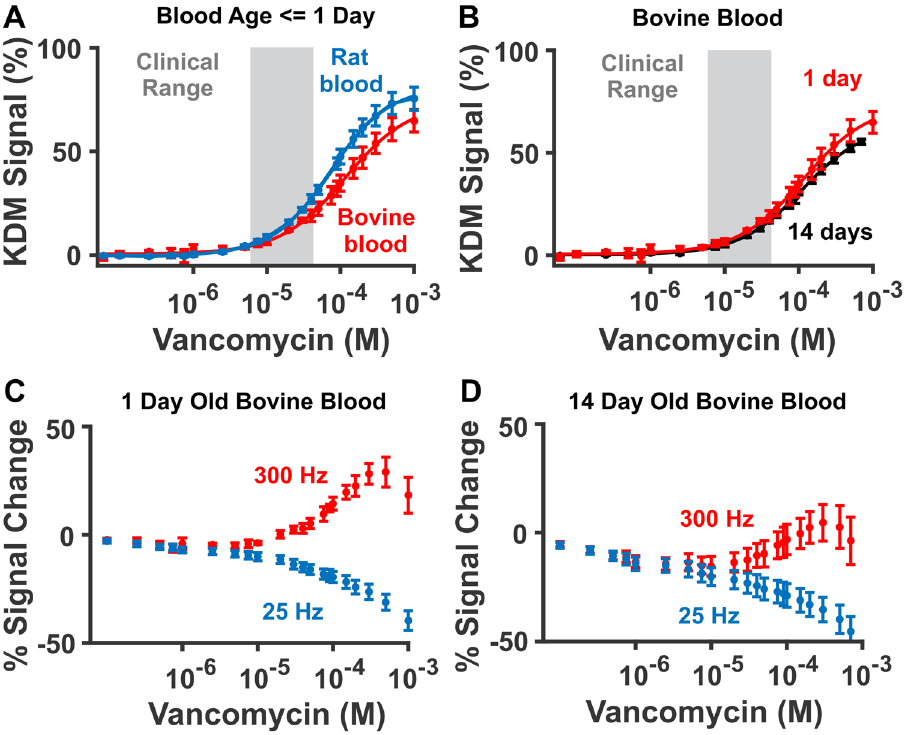
Figure 5. ( A ) Titrations performed in fresh rat blood and commercially sourced, one-day-old bovine blood produce distinct calibration curves. ( B ) To determine whether this is driven by species-specific differences in blood, or the greater age of the commercially sourced bovine blood, we compared calibration curves obtained in a bovine blood sample 1 day (red, K 1/2 = 116 ± 15 µM) and 14 days (black, K 1/2 = 112 ± 9 µM) after it was collected. Doing so, we find that the KDM response does not change significantly in the clinical range. ( C, D ) Examining the signal at the two square-wave frequencies used to perform KDM (here, 25 Hz and 300 Hz) we see that, for the 14-day-old blood, there is a notable signal decrease at vancomycin concentrations far below the aptamer’s dissociation constant. Given that no target-induced response should occur at these low concentrations, we believe this is an artifact due to time-dependent sensor degradation in the older